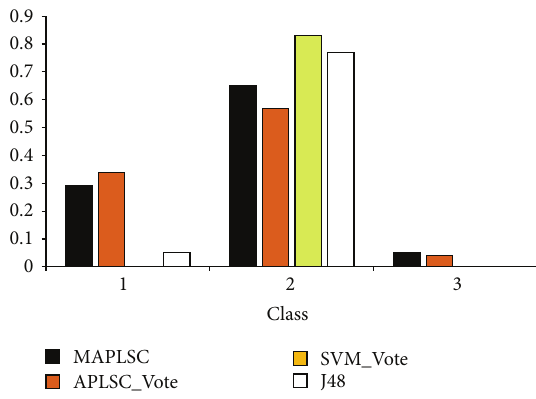
Figure 7: 𝐹1 -measure of each class syndrome